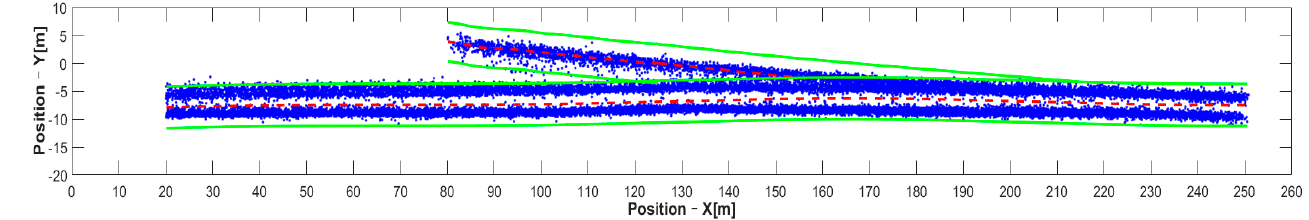
Figure 5. Lane identification in research area.